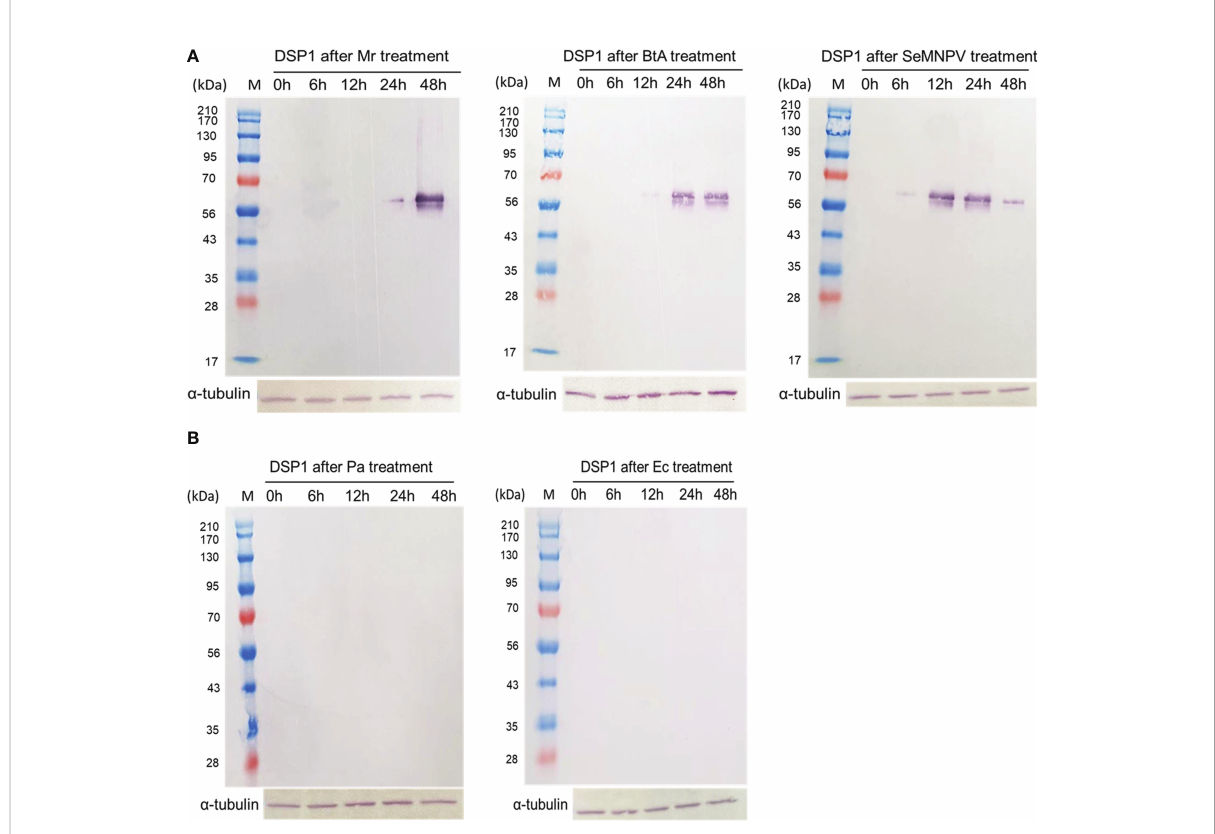
FIGURE 6 Release of Se-DSP1 into plasma upon infection of different microbes. Western blotting shows the release of Se-DSP1 into plasma upon gut infection by (A) entomopathogenic fungus, M . rileyi ( ‘ Mr ’ ), entomopathogenic bacterium, B. thuringiensis subsp. aizawai ( ‘ BtA ’ ), a baculovirus ( ‘ SeMNPV ’ ), and (B) non-pathogenic bacteria, E. coli ( ‘ Ec ’ ) and P . agglomerans ( ‘ Pa ’ ). Hemolymph was collected and plasma was separated at 0- 48 h PI. Se-DSP1 antibody was used to detect DSP1 in plasma where a -tubulin was used as a reference to con fi rm the equal amount of protein